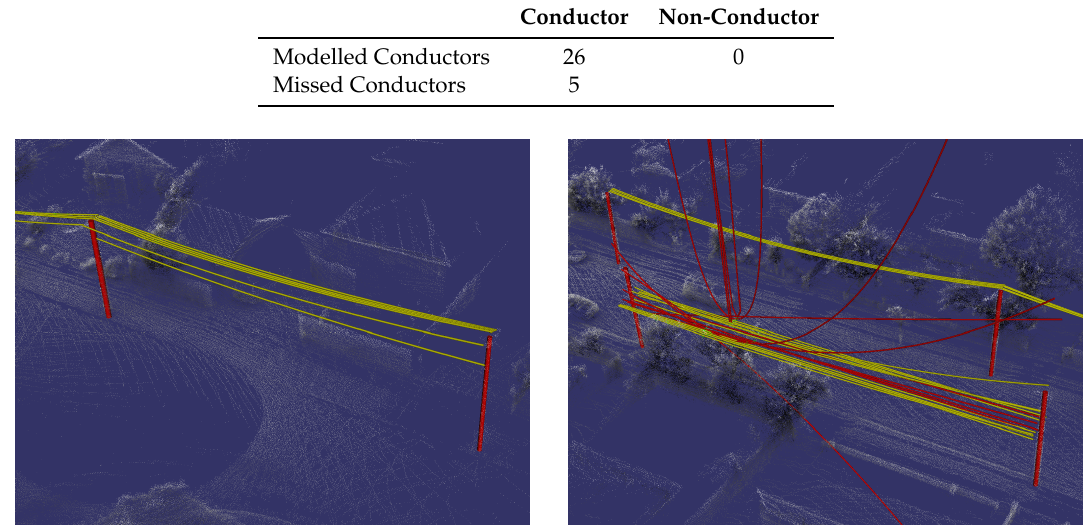
Figure 11. Removing the requirement that a conductor cluster must have points distributed along the entire span can increase conductor recovery in less well-observed regions ( left ) at the cost of less robust rejection of non-conductor objects on the clustering plane ( right ).